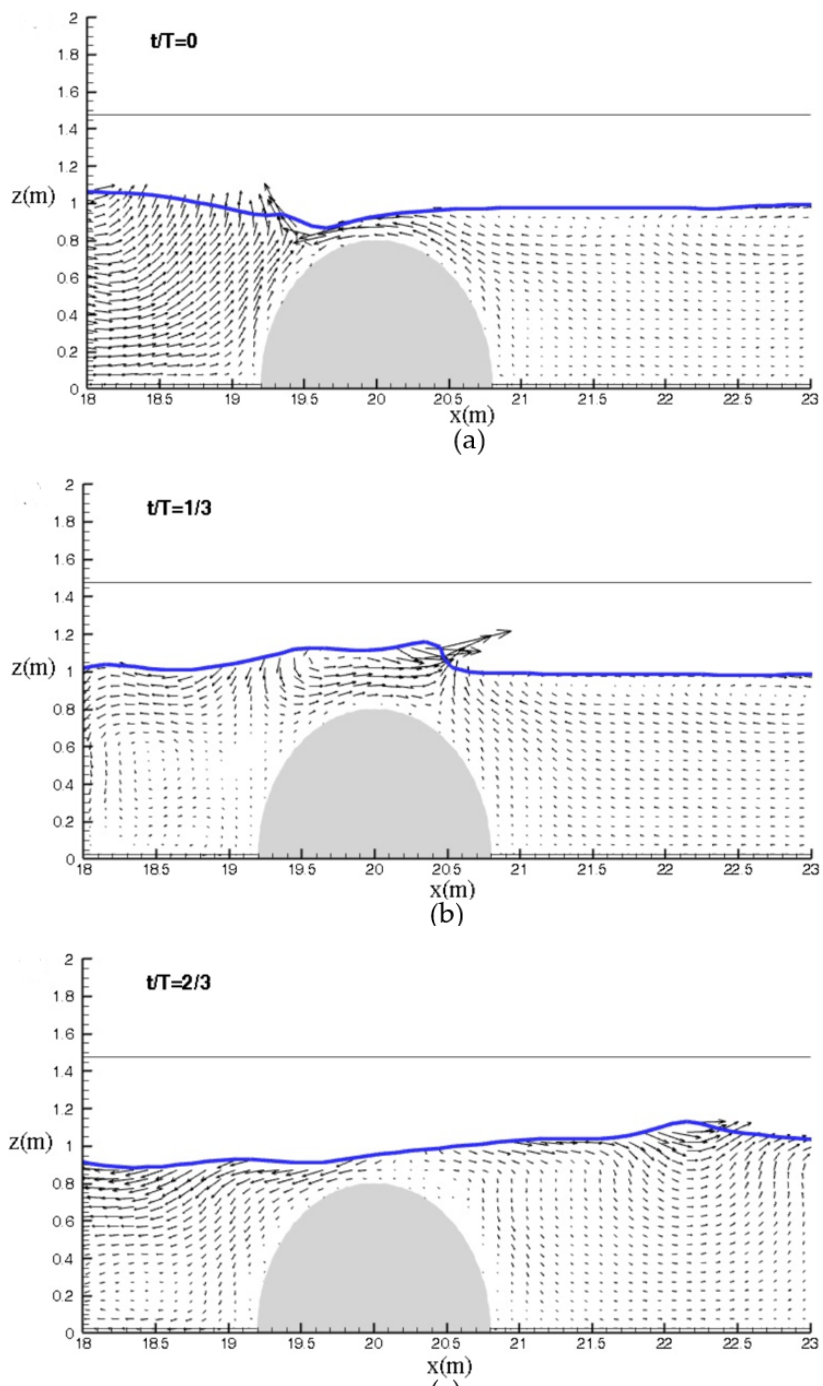
Figure 13. Instantaneously velocity fields for the monochromatic wave with H i = 0.2 m and T = 3 s passing over the semicircular submerged structure for ( a ) t/T = 0 , ( b ) t/T = 1/3 , and ( c ) t/T = 2/3 . The flow patterns around the obstacle are compared between three types of submerged structures as shown in Figure 14 with the generation of the incident wave period T = 3 s at t = 40 s. The temporal condition indicates the wave crest just over the top surface of the embedded objectives. For the three shapes, the velocity profiles with significant gradient are observed at approximately the equivalent locations occurring over the windward slopes. Figure 14a shows that the velocity distribution around the semicircle is in analogous to the condition presented in Figure 13b, however, with the increase of the secondary vortex in front of the left-toe of the obstacle. Different from the semicircle, a vortex appears upstream of the trapezoidal body as well as another vortex behind the trapezoidal structure. This circumstance is not observed for the other two solid objectives, which suggests that the trapezoidal shape gives rise to a larger form drag with the wave generated water flow over the immerged body. There is only a small vortex formed backward slope of the triangular bar, implying the relatively small drag force. The substantially different distribution of the velocities due to the shape of structures produced a significant effect on the hydrodynamic force when the wave is acting on the structure. This phenomenon is further discussed in Section 3.3.3.